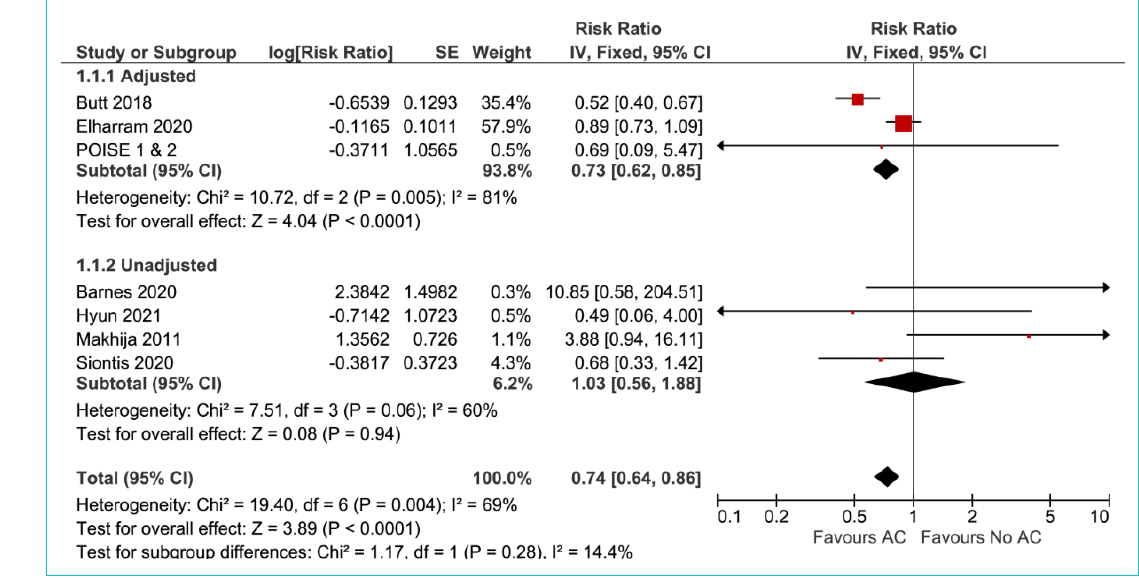
Figure 1: Forest plot for stroke ± systemic embolism stratified by the use of multivariable adjustment. AC: